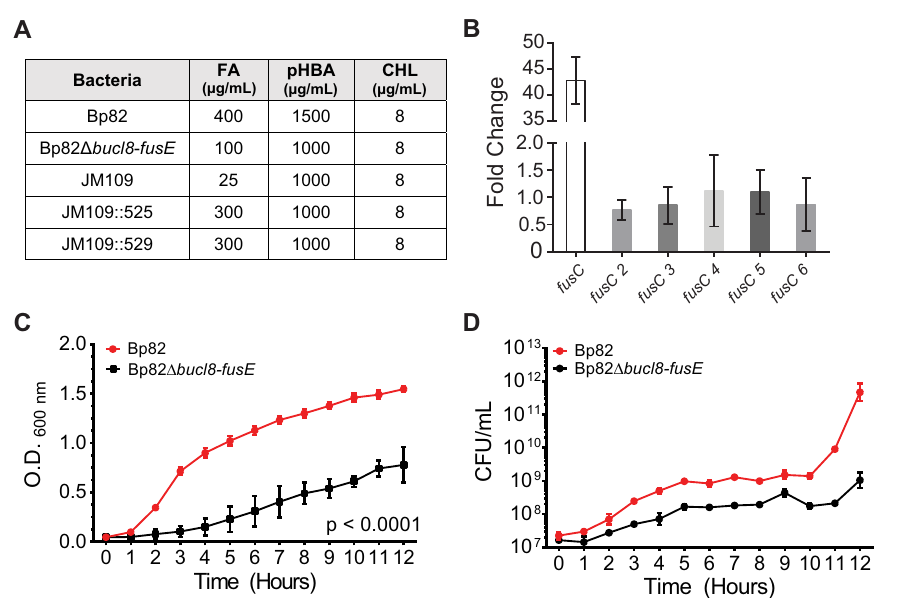
Fig 6. Analysis of loss-of-function and gain-of-function associated with chromosomal deletion and in-trans complementation of Bucl8-pump components. (A) Changes in sensitivity/resistance patterns in bacterial strains. MIC was determined by plating bacteria on LA containing each substrate. FA, fusaric acid; pHBA, para- hydroxybenzoic acid; CHL, chloramphenicol. (B) Relative expression of fusC genes. RT-qPCR was performed on total mRNA isolated from non-treated and FA-treated (1000 μ M, 1 hour) Bp82 cultures (OD 600 ~0.4). Graph shows fold change of relative gene expression compared to untreated cultures and normalized to 16S rRNA. Technical and experimental replicates were done in triplicate. (C-D) Effect of chromosomal deletion on growth. Parental strain Bp82 and its bucl8-fusE deletion mutant (Bp82D bucl8-fusE ) were grown in LBM broth at 37˚C with shaking. Changes in OD 600 (C) were recorded and CFU numbers (D) by plating on LA medium every hour. Data represents the average of three biological replicates. 2-way AVOVA with Tukey multiple comparison test, ��� p < 0.001. Error bars represent ±